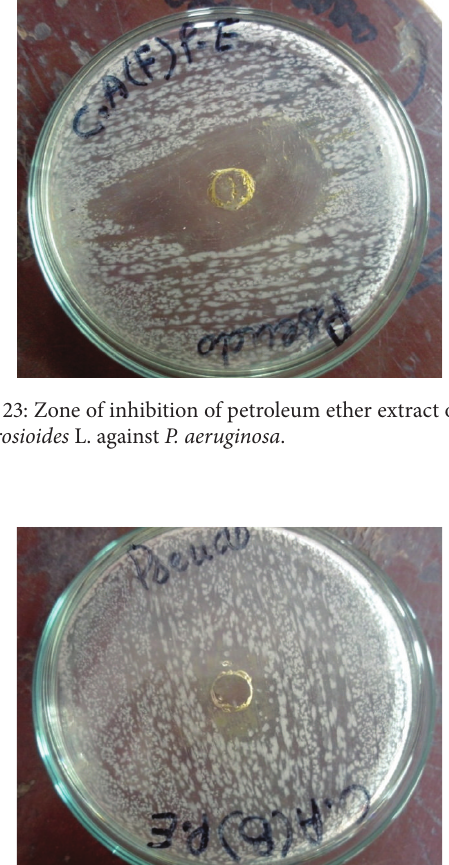
Figure 21: Zone of inhibition of methanol extract of bark of C. ambrosioides L. against B. subtilis.